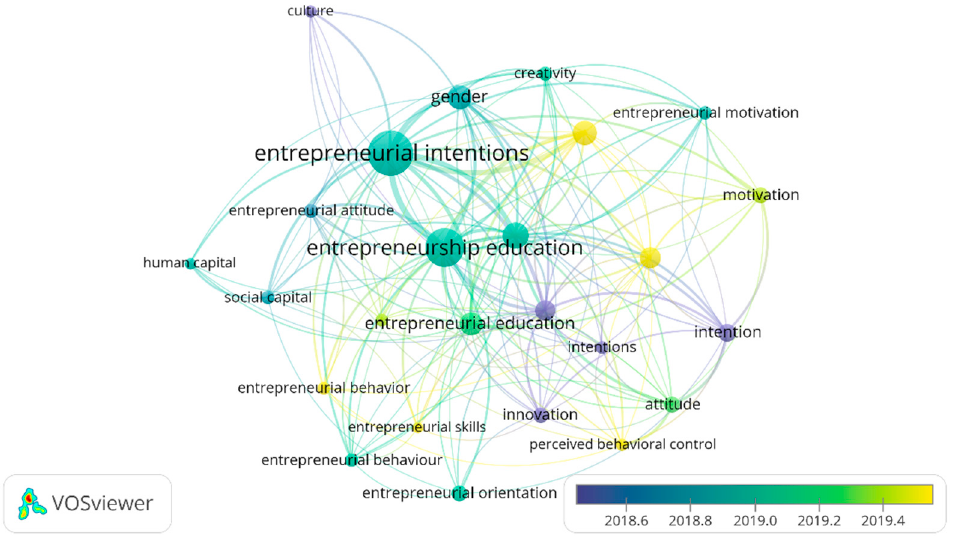
Figure 2. Overlay visualization (entrepreneurial intention—SCOPUS).